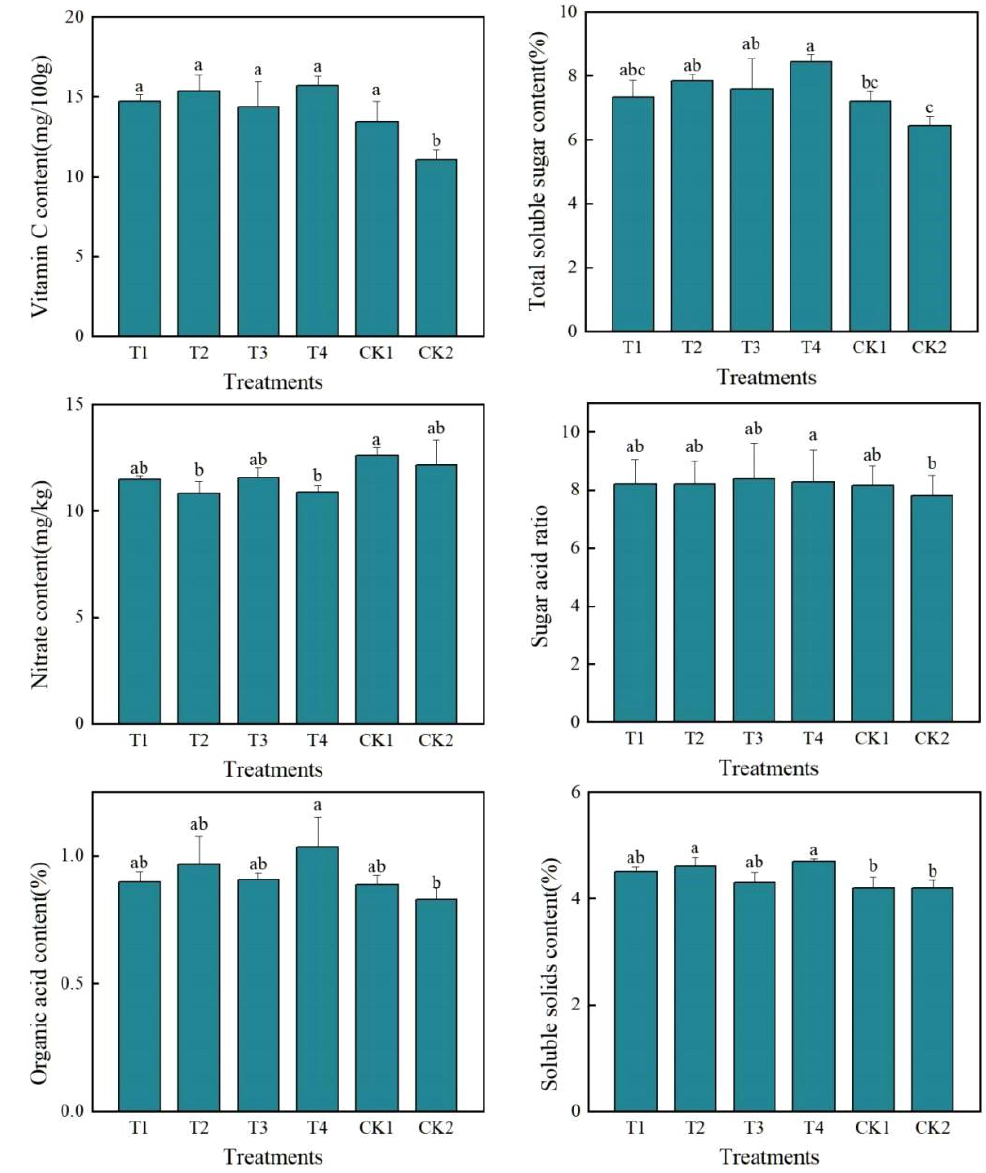
Figure 5. Effects of different heating treatments on fruit quality parameters. Note: different lowercase letters in the same column in the figure indicate that the difference between different treatments reaches a significant level of p < 0.05.